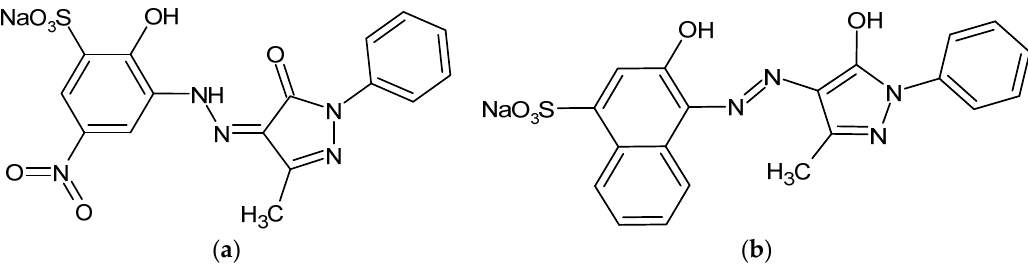
Figure 1. Chemical structure of the acid mixture (AM): ( a ) Acid Violet 90 (AV90); ( b ) Acid Red 357 (AR357), azo dyes molecules.